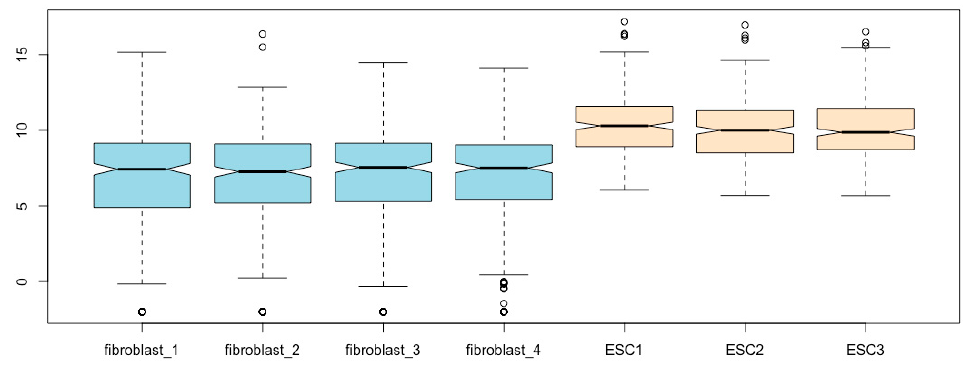
Figure 8. Fill box bodies with different colors for different cell types.